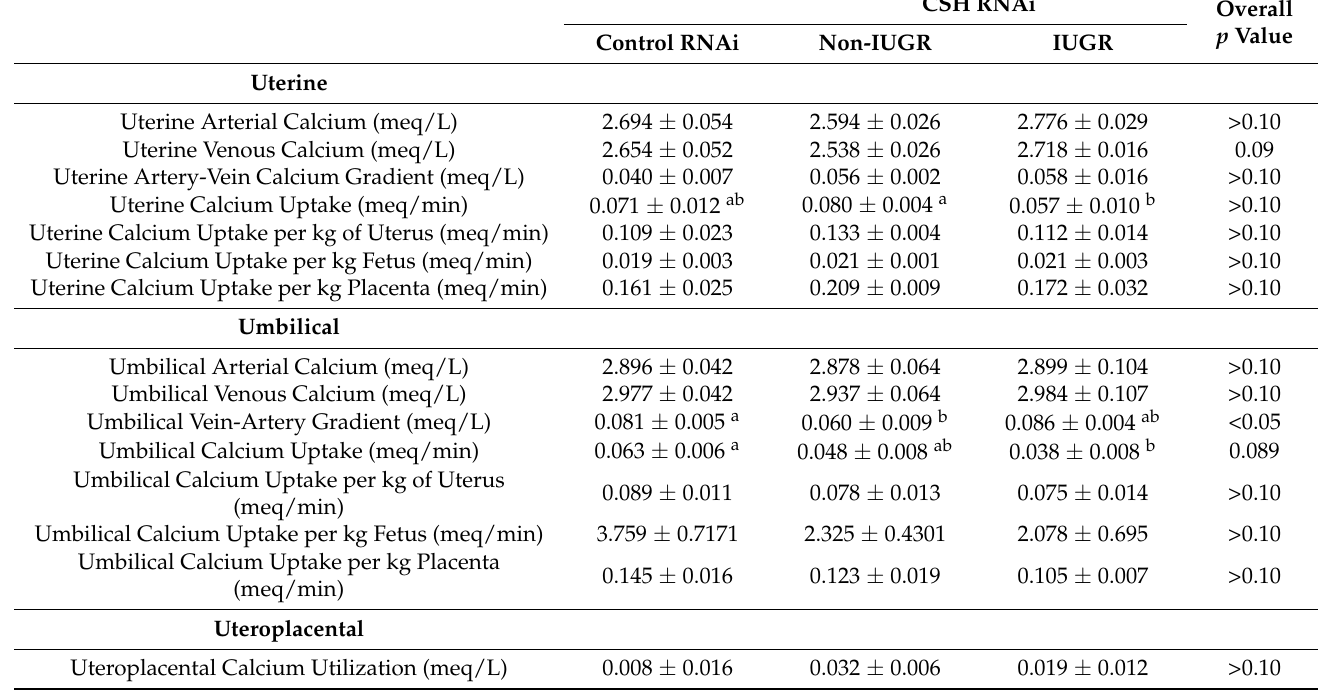
Table 1. Effect of CSH RNAi on serum calcium abundance. Data are presented as means ± SEM. Different superscripts indicate statistical significance. (Control RNAi n = 10; CSH RNAi Non-IUGR n = 6; CSH RNAi IUGR n = 4). CSH, chorionic somatomammotropin; IUGR, intrauterine growth restriction; N/A, samples/results not available; RNAi, RNA interference.